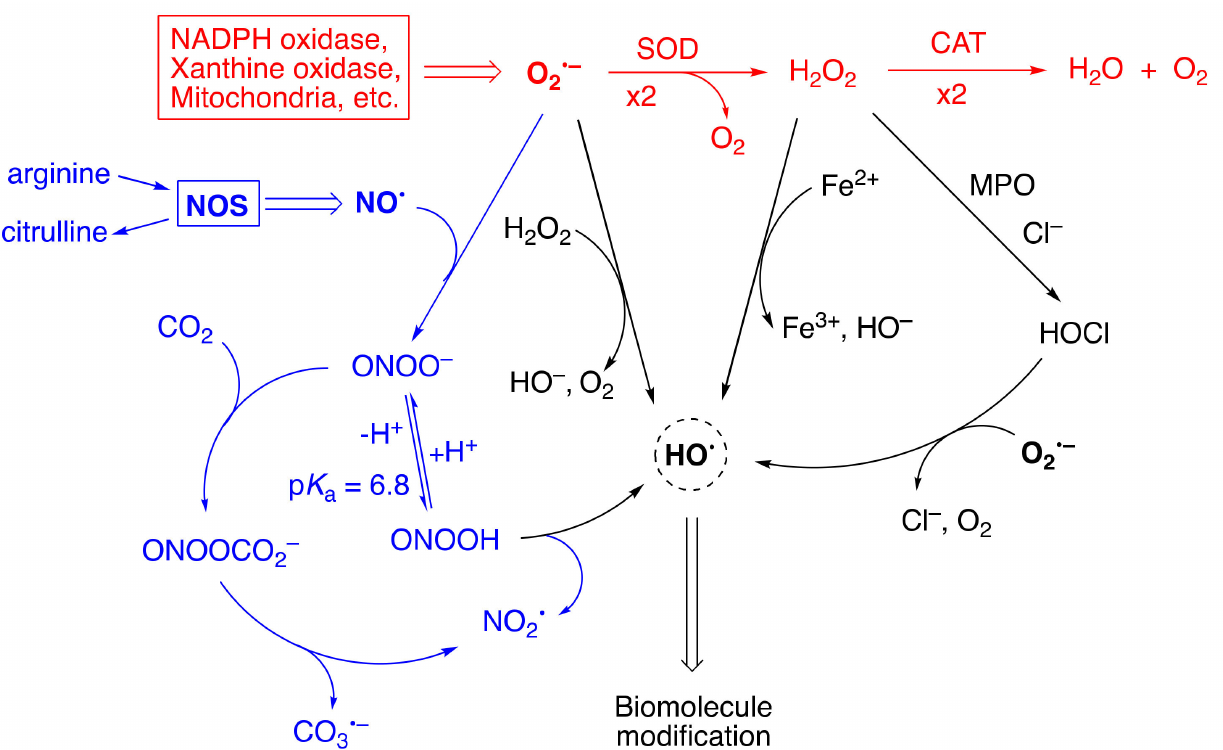
Figure 2. Pathways of interaction of superoxide and nitric oxide in biological systems. NOS: nitric oxide synthase; SOD: superoxide dismutase; CAT: catalase; MPO: